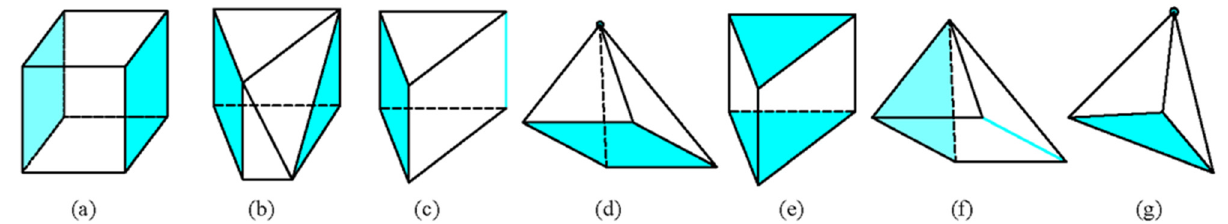
Figure 1. Basic element types: ( a ) transition from quadrilateral to quadrilateral; ( b ) transition from quadrilateral to triangular; ( c ) transition from quadrilateral to straight line; ( d ) transition from quadrilaterals to a point; ( e ) transition from triangular to triangular; ( f ) transition from triangular to line; ( g ) transition from triangular to a point